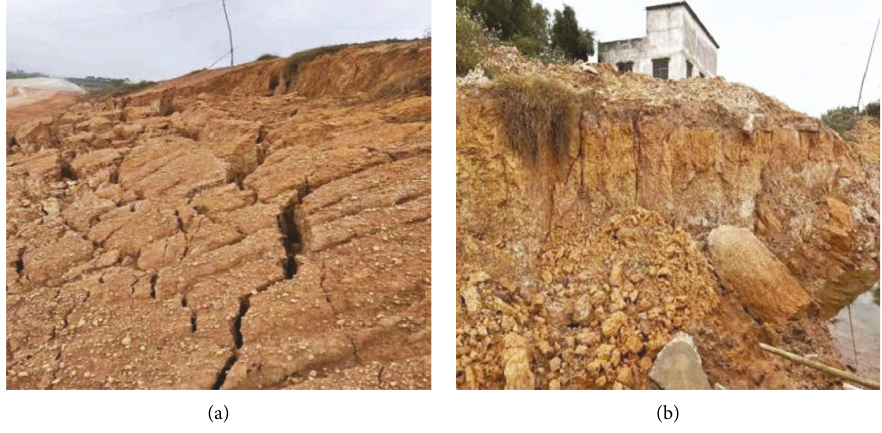
Figure 1: Cracking and collapse of expansive soil slopes.